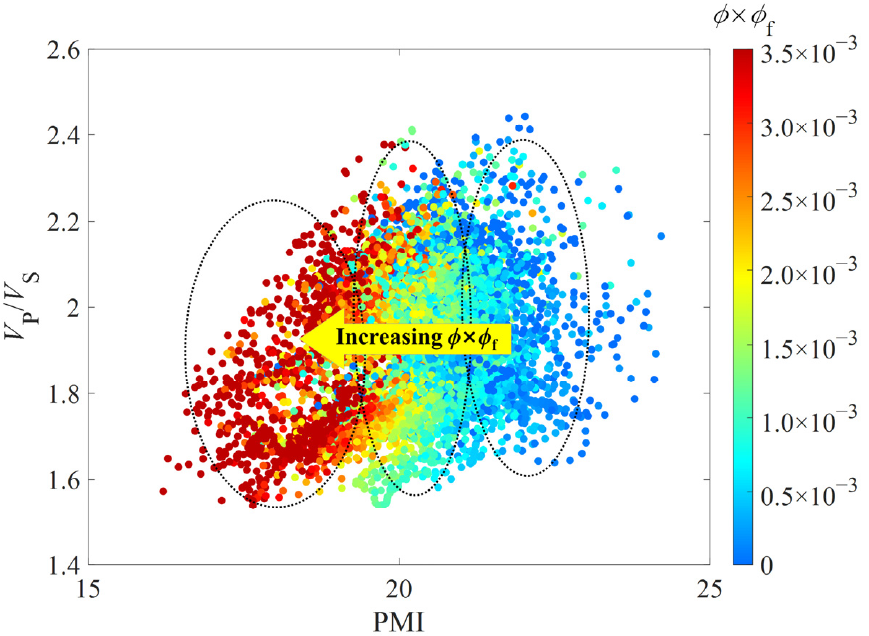
Figure 11. Cross-plot of V P / V S and PMI at θ max = 101° color-coded by ϕ × ϕ f .